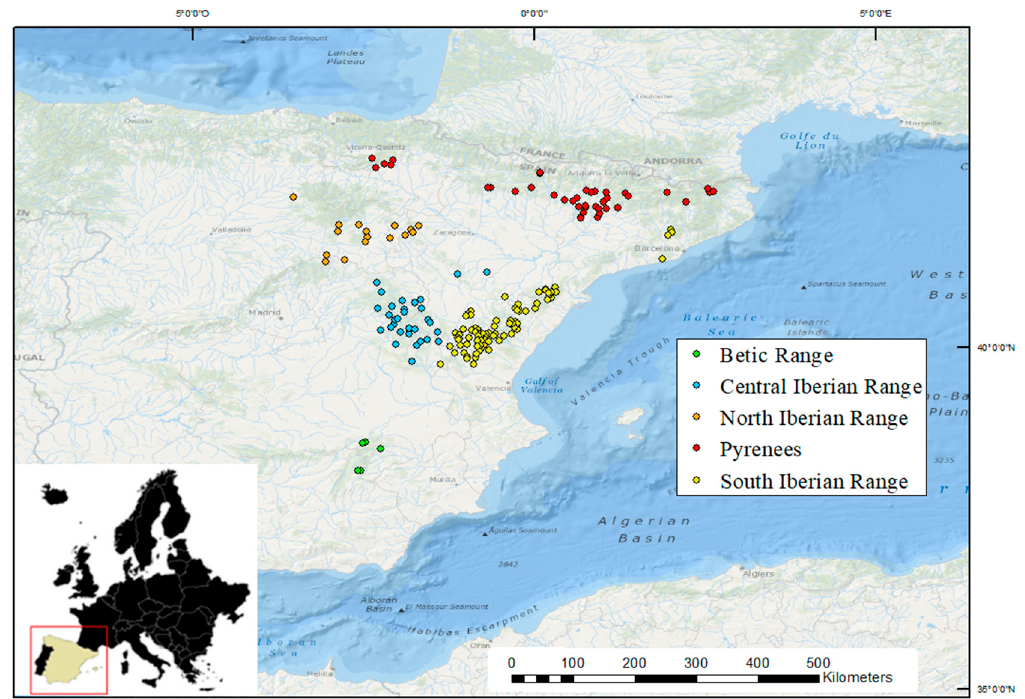
Figure 1. Black truffle production locations.